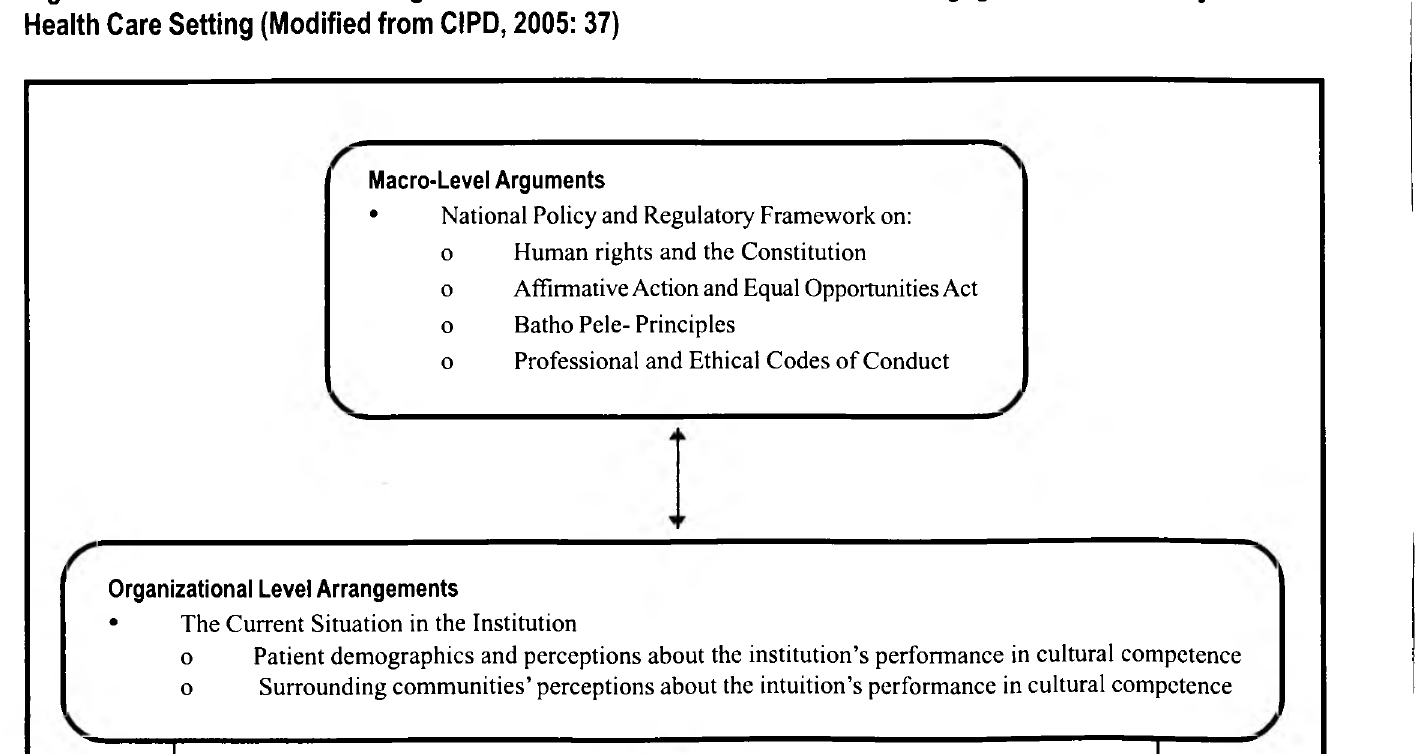
Figure 1: A Framework for Setting the Context for Constructive and Critical Engagement on Diversity in the Health Care Setting (Modified from CIPD, 2005: